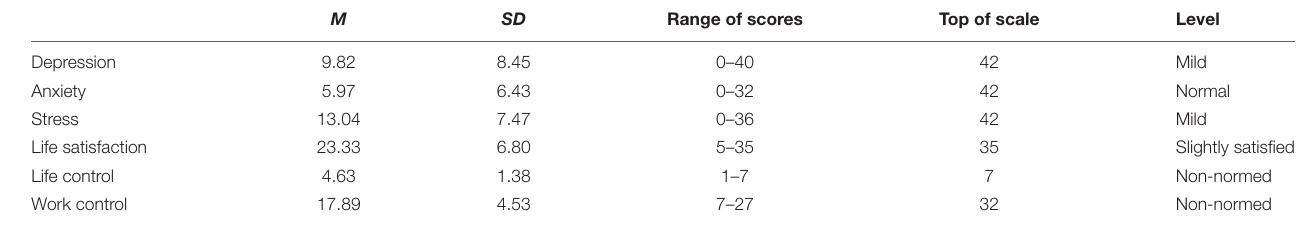
TABLE 1 | Descriptive statistics of mental health variables in Study 2.